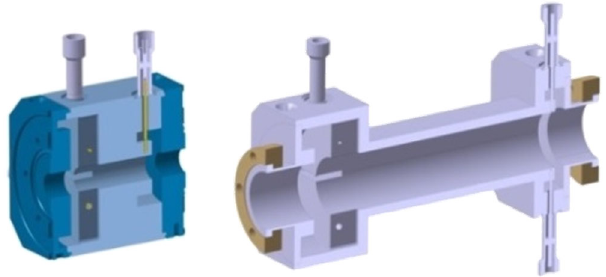
FIG. 7. 3D model cross-section view of the SwissFEL CBPM16 (left) and CBPM38